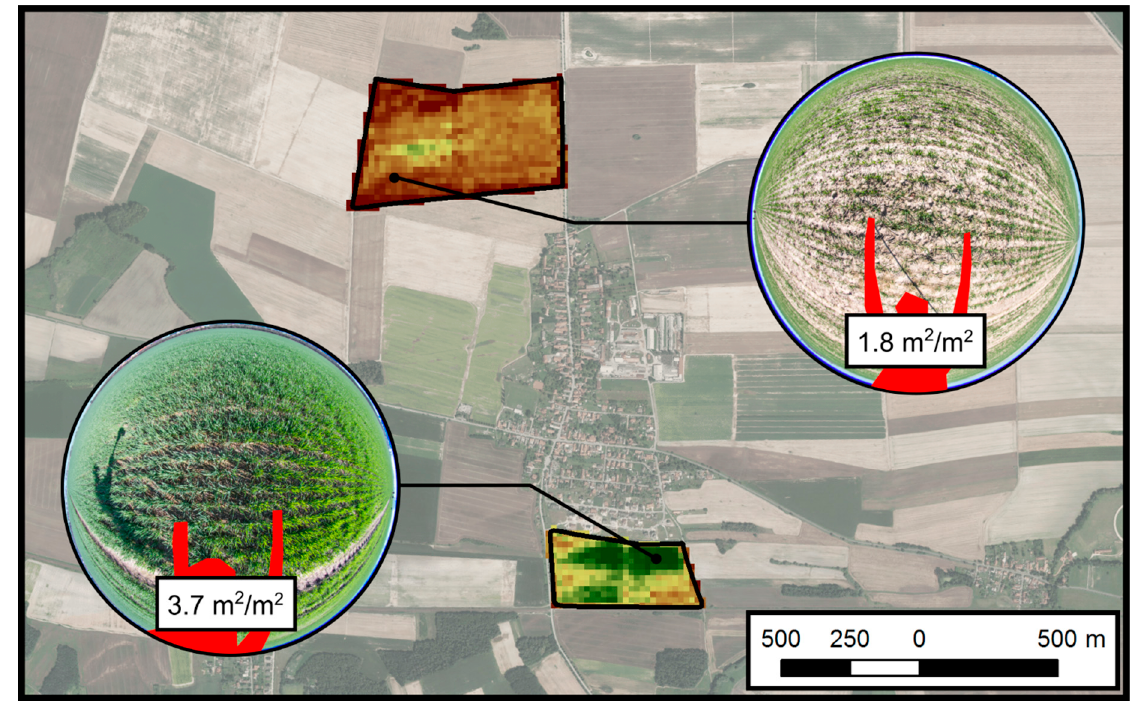
Figure 13. Example of leaf area index (LAI) estimation for two winter wheat parcels demonstrating differences in crop canopy status of the winter crops at the beginning of the new vegetation season (1 April 2017).